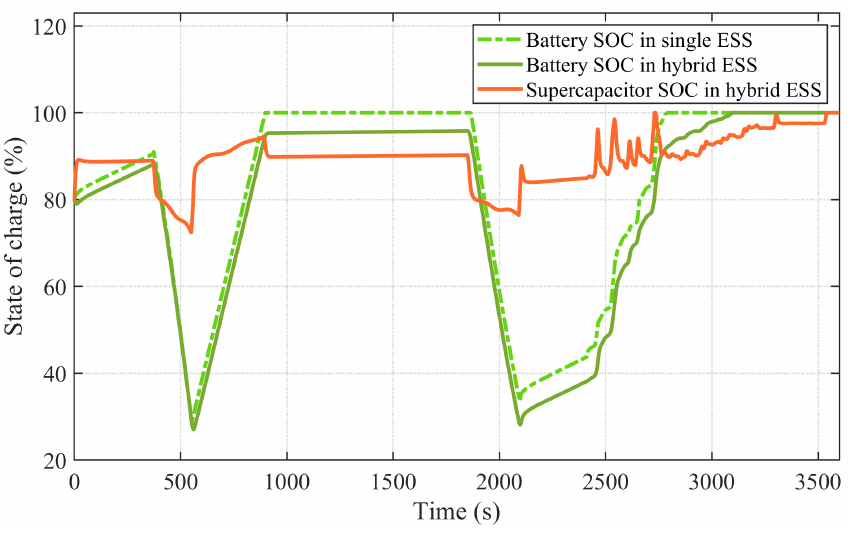
Figure 18. The SOC of energy storage devices in the single and hybrid ESS.